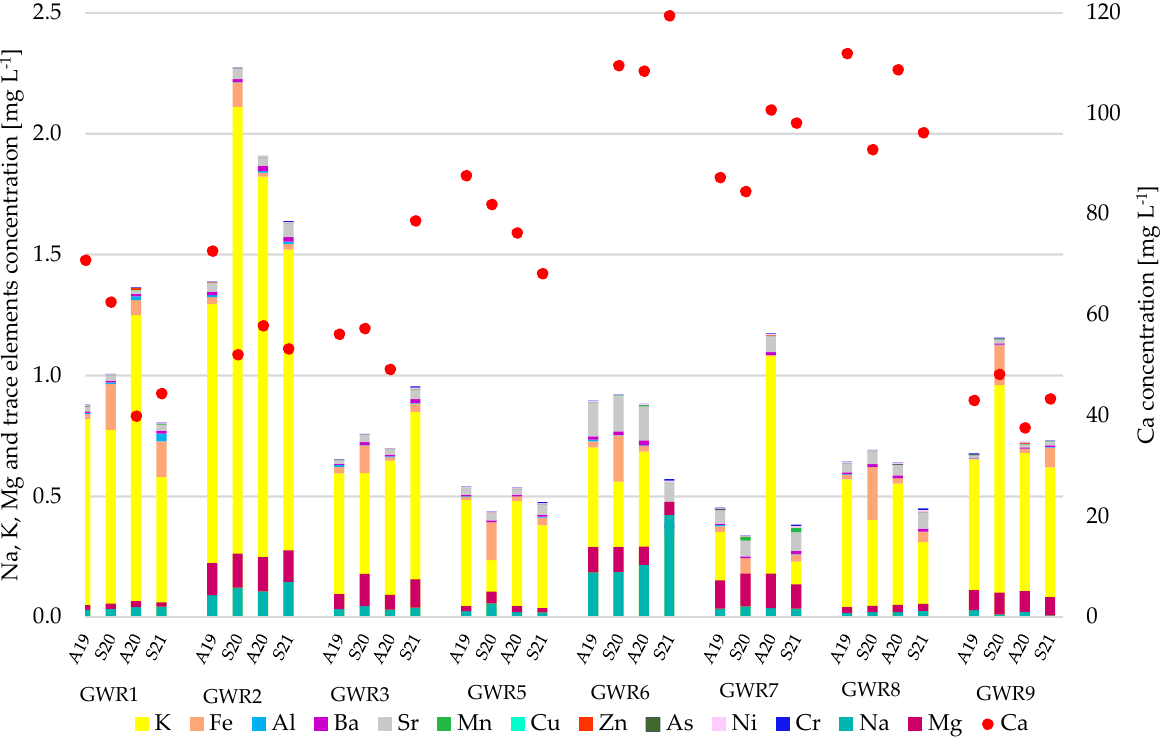
Figure 3. Temporal variation of elements concentration in the studied spring waters.